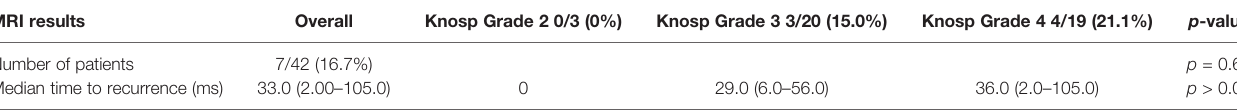
TABLE 5 | Recurrence outcome of included patients with initial remission based on Knosp grade.